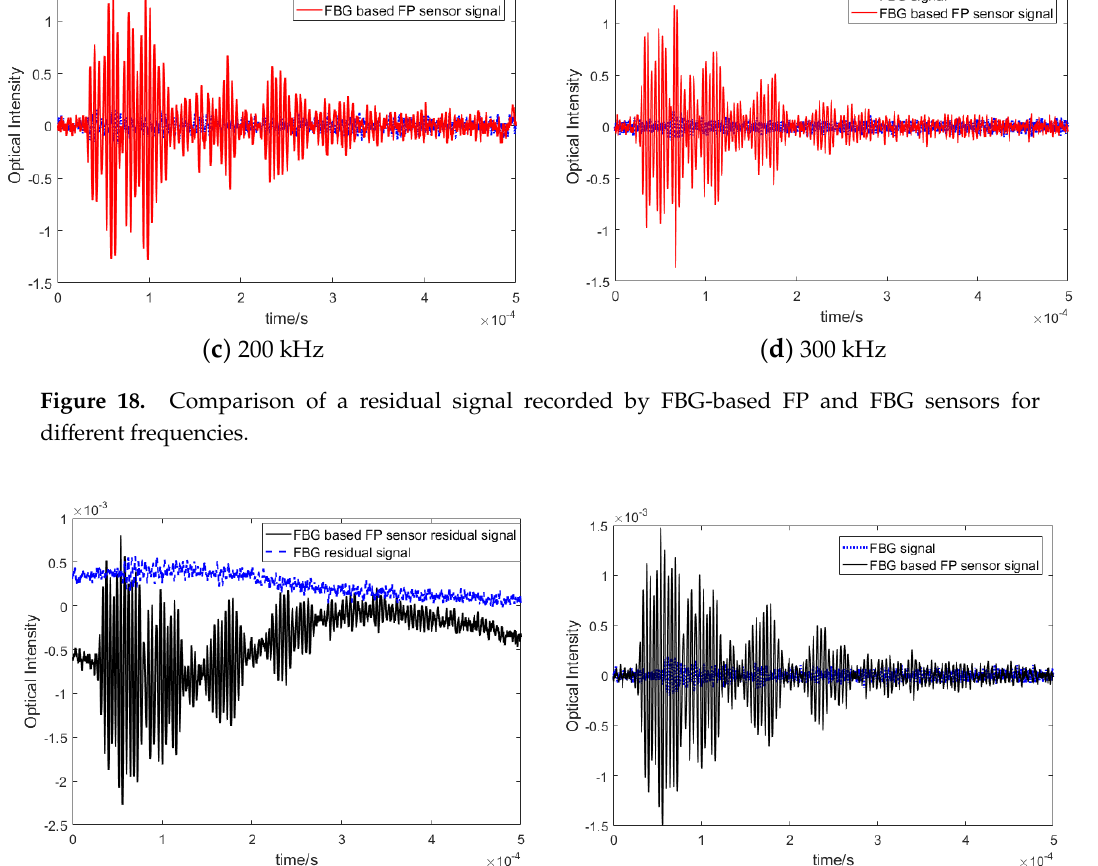
Figure 19. Comparison between FBG-based FP sensor and FBG residual signals under environmental conditions – 250 kHz excitation. conditions—250 kHz